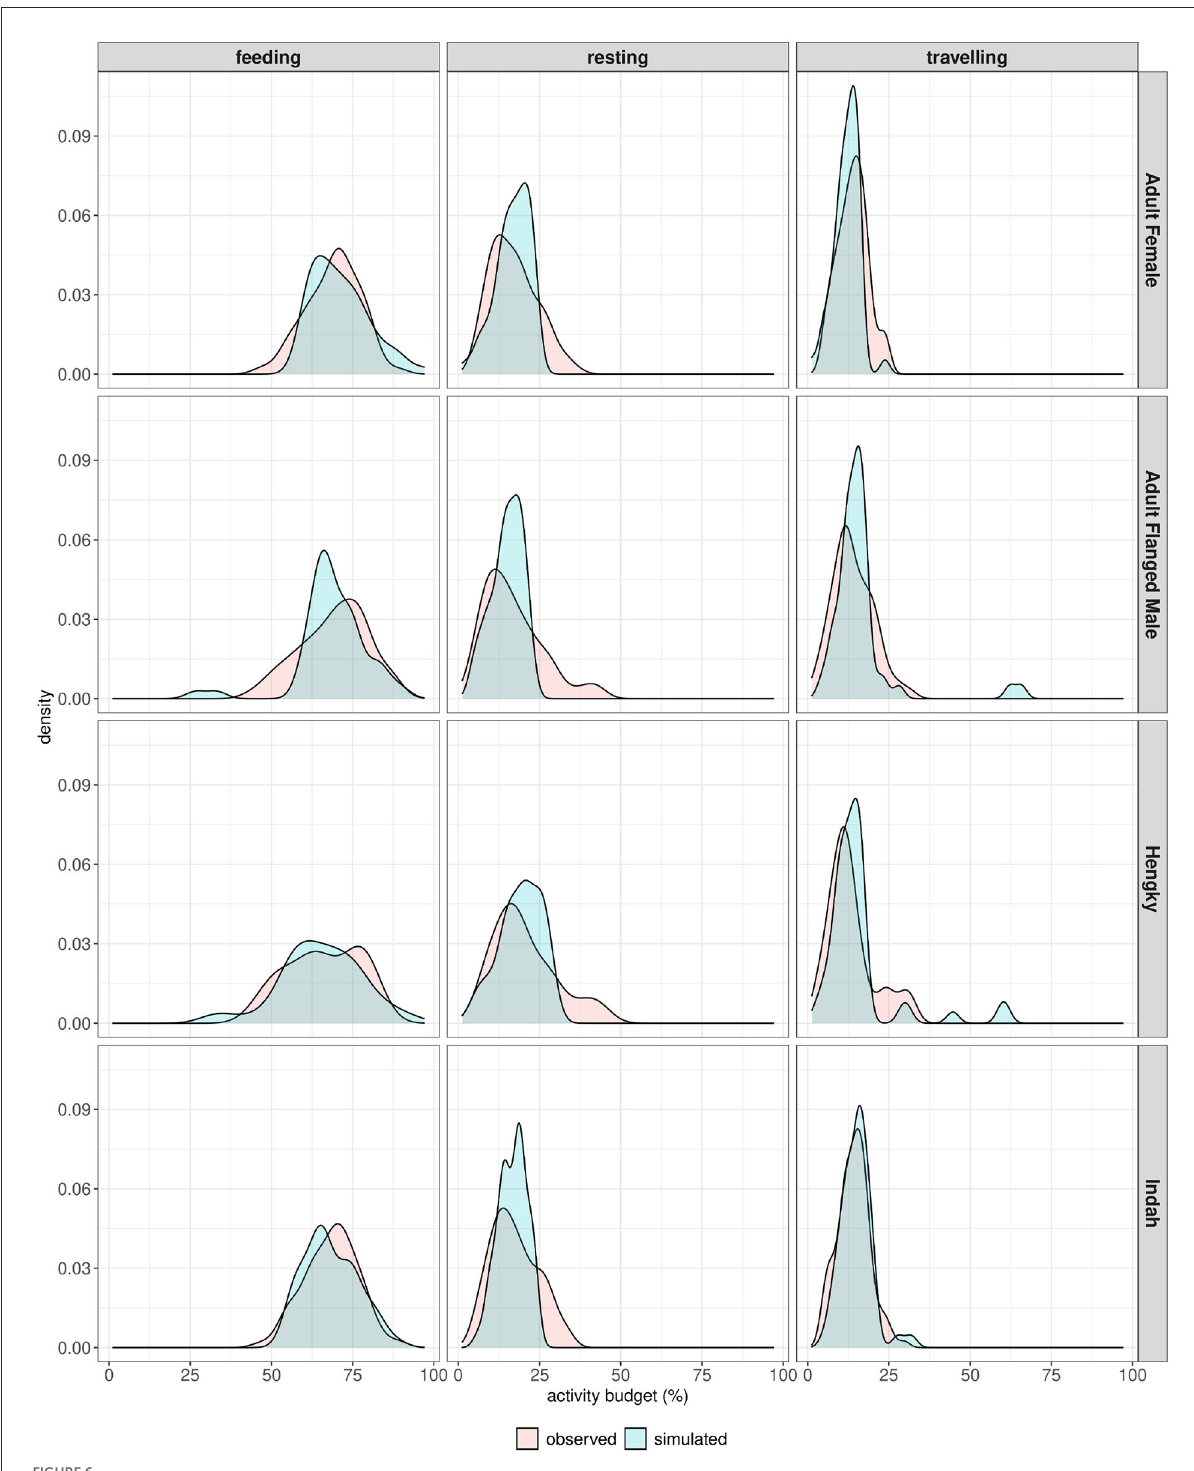
FIGURE6 Calibration results to model with selected parameter set. The simulation result (in blue; 50 replicated simulations of one individual) is then compared to the observational data of orangutans follows (in red; refer to Table 2). We compared feeding, resting, and traveling, respectively. Note that we selected one out of several possible solutions shown in Section 3 of Supplementary material